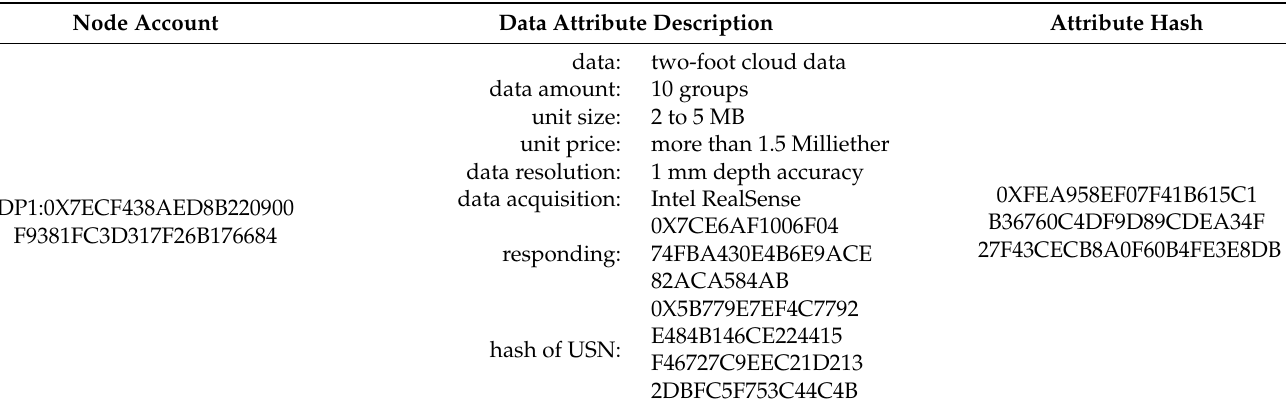
Table 4. The DP data attribute